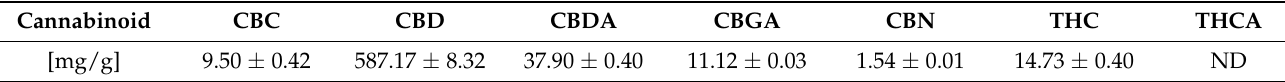
Table 1. Content of cannabinoids in hemp-ginger extract.